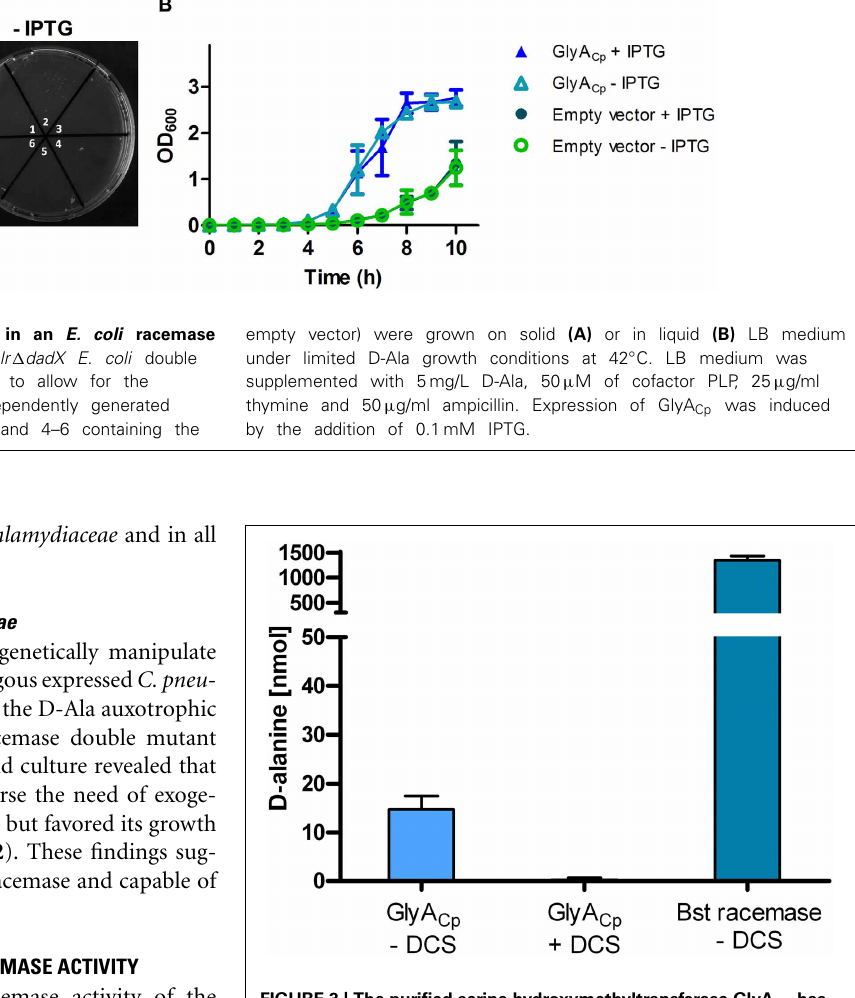
FIGURE 3 | The purified serine hydroxymethyltransferase GlyA Cp has alanine racemase activity. In vitro activity of recombinant GlyA Cp was tested in a coupled enzymatic assay containing L-Ala and cofactor PLP. D-Ala that was produced by 1 μ g GlyA or Bst racemase was converted to pyruvate by the activity of DAAO and colorimetrically quantified. (DCS: D-cycloserine; Bst racemase: alanine racemase from B. stearothermophilus